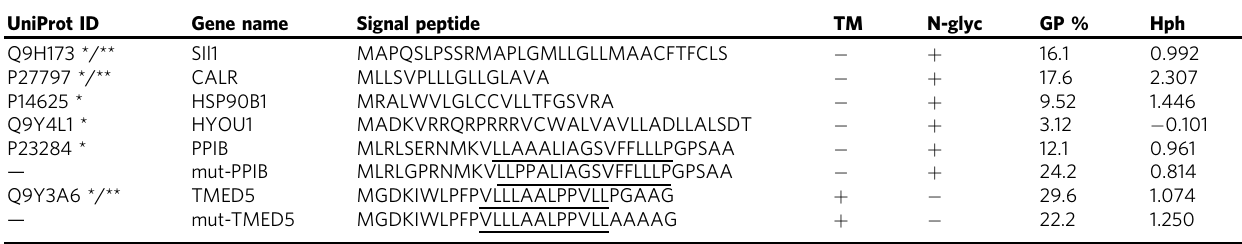
Aminoacidsequencesofsignalpeptides(SP)areshowntogetherwithproteinaccessionnumber,genename,presenceoftransmembranedomains(TM)orN-glycosylationsites(N-glyc),GPcontentin %, and hydrophobicity (Hph). Signal peptides are divided into N-terminal, hydrophobic, and C-terminal domains according to Phobius prediction (www.phobius.sbc.su.se). *, accession numbers of proteins,whichwerealsonegativelyaffectedbySec61complexdepletion;**,validatedproteins.TMED5wascopiedfromTable1forcomparison.MutatedvariantsofTMED5andPPIBweregeneratedby quick change mutagenesis in one and two steps, respectively, and veri fi ed by sequence analysis. The CALR genes codes for Calreticulin, the HSP90B1 gene for Grp94, the HYOU1 gene for Grp170. mut,